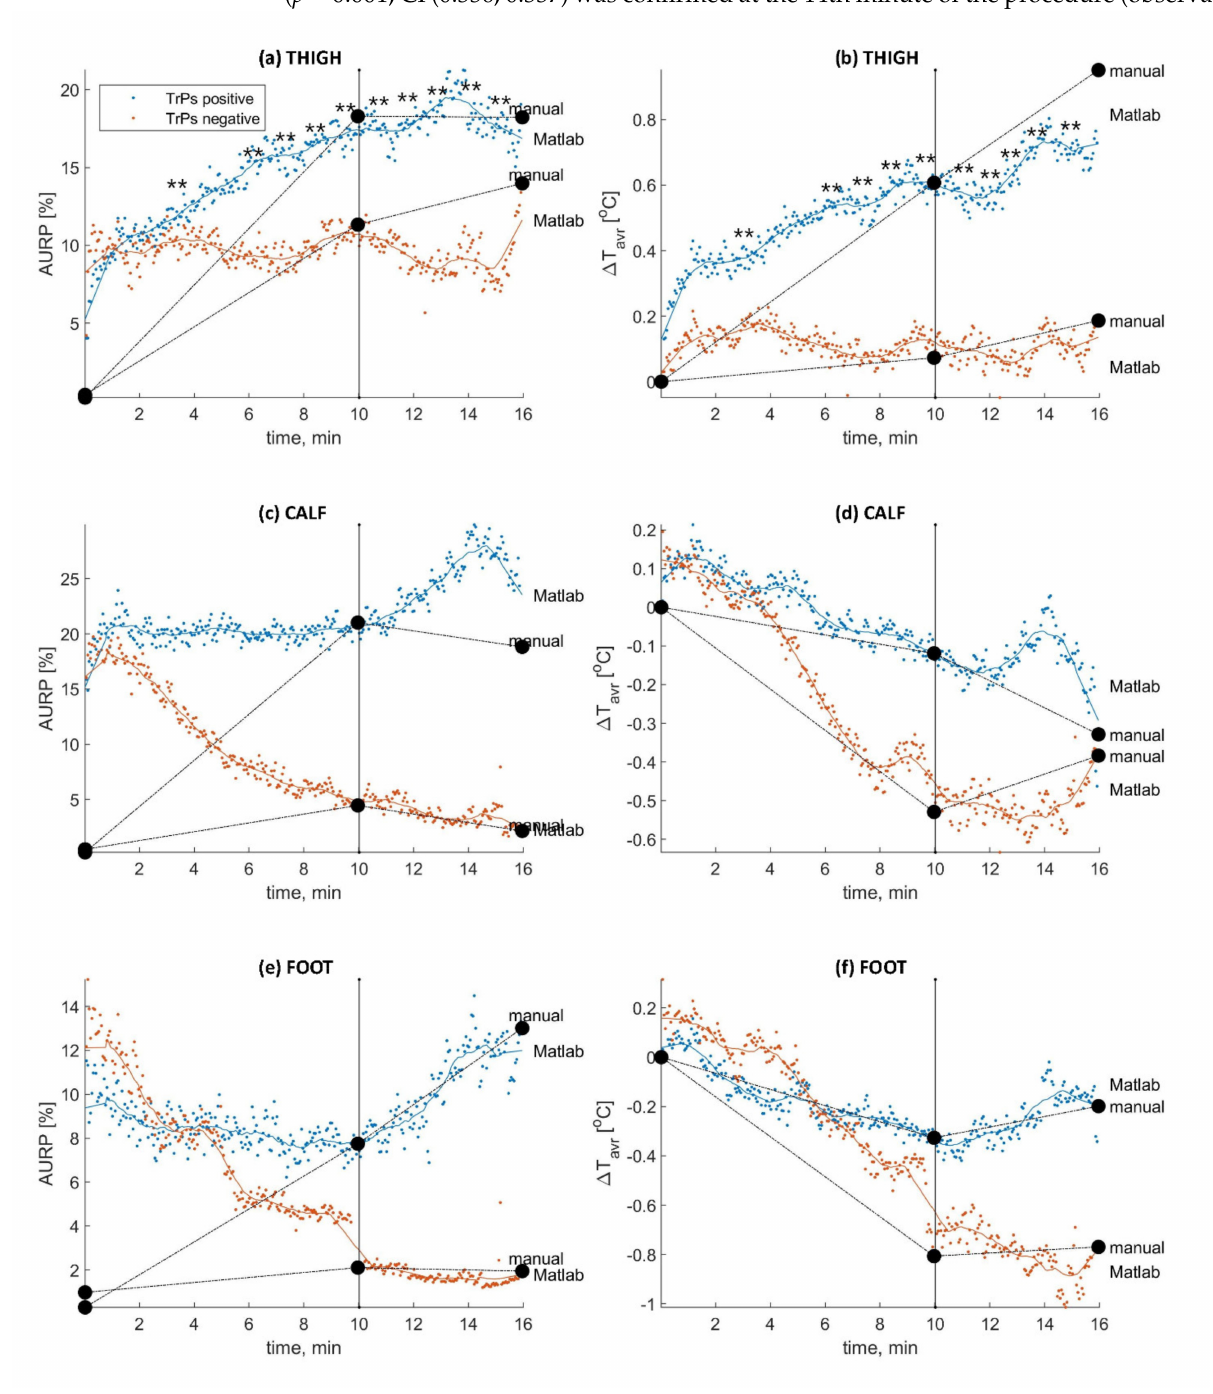
Figure 6. MATLAB trends for ∆ Tavr and AURP for each anatomical ROI (thigh ( a , b ), calf ( c , d ), and foot ( e , f )) in relation to the TrP